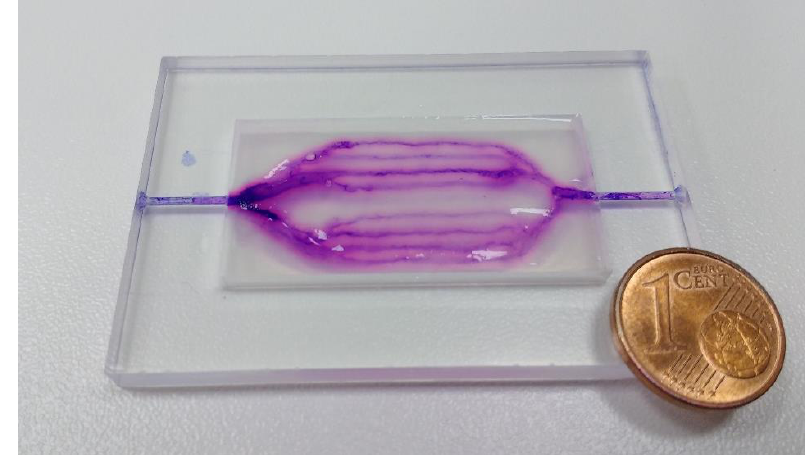
Figure 6. Alginate-based microfluidic device in the shape of 2D branched structures. Perfusion was tested using violet ink (Pelikan 4001), residues of which are visible in the photograph. The same sample frame and fabrication parameters were used here, as shown in Figure 3a.